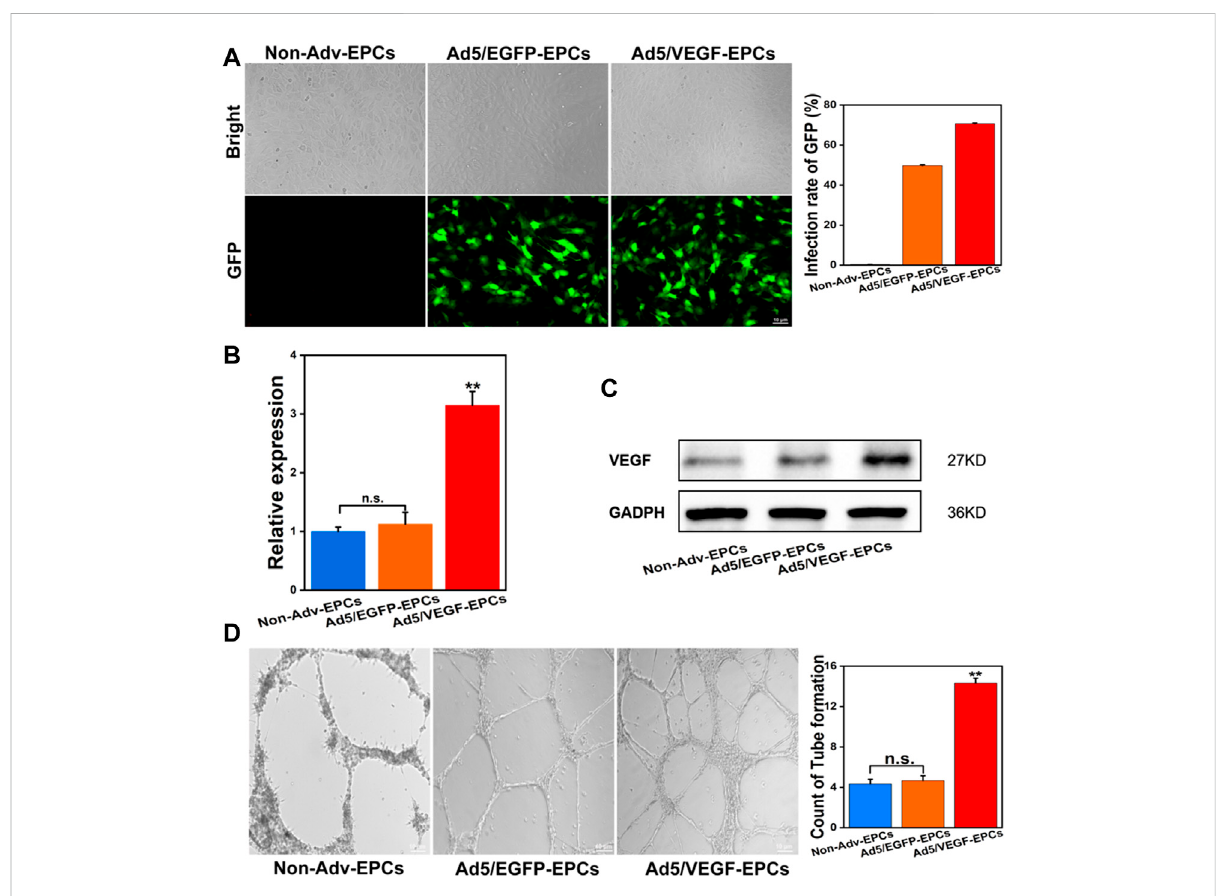
FIGURE 2 Ad5/VEGF transduction upregulates VEGF expression and improves tube-formation capacity of EPCs. (A) Identi fi cation of EPCs transducted by Non-Adv, Ad5/EGFP, and Ad5/VEGF by enumerating GFP-positive cells; the graph shows the transduction rate of GFP. (B) VEGF mRNA expression was determined using qPCR; actin was used as control. (C) VEGF protein expression was assessed by western blotting; GAPDH was used as control. ThegraphshowsaremarkableincreaseinVEGFexpression. (D) Tubeformationinmatrigelonday14;thenumberoftubesformedareindicated in the